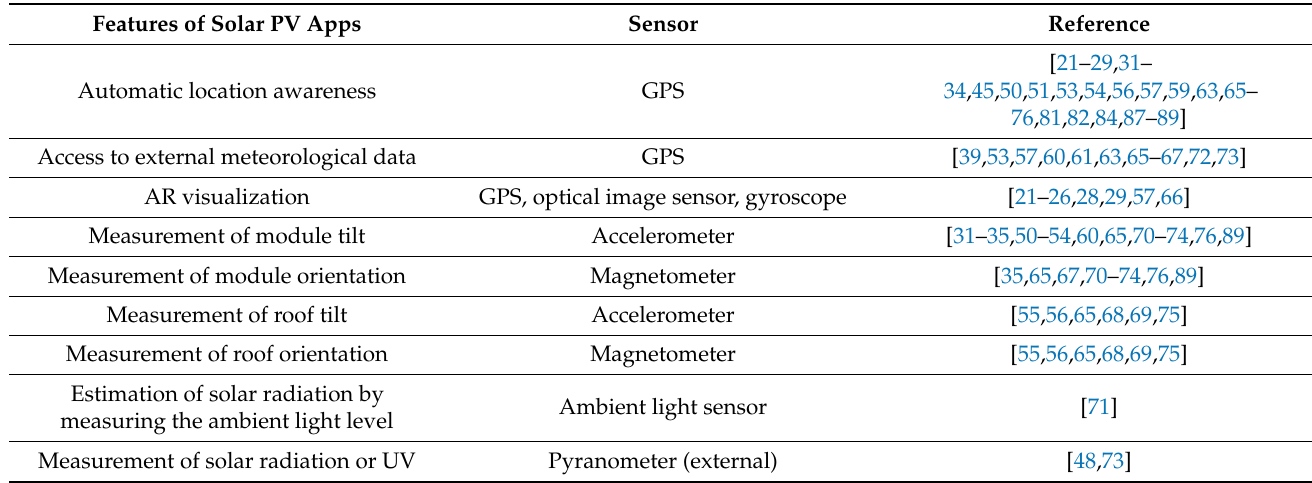
Table 11. Sensing features of solar PV apps and corresponding hardware sensors of